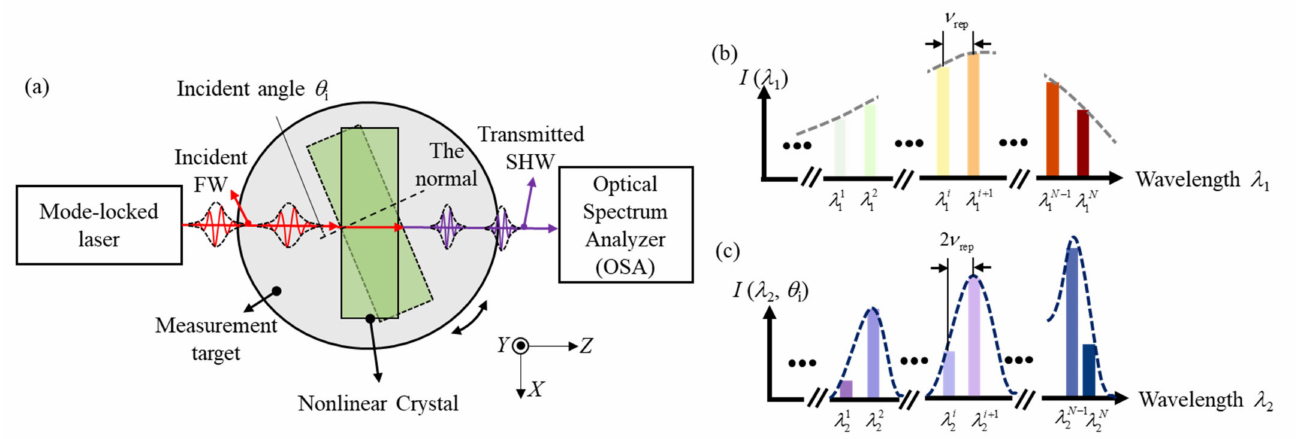
Figure 1. ( a ) The schematic of angle measurement based on SHG; ( b ) the spectrum of incident femtosecond laser; ( c ) the spectrum of transmitted